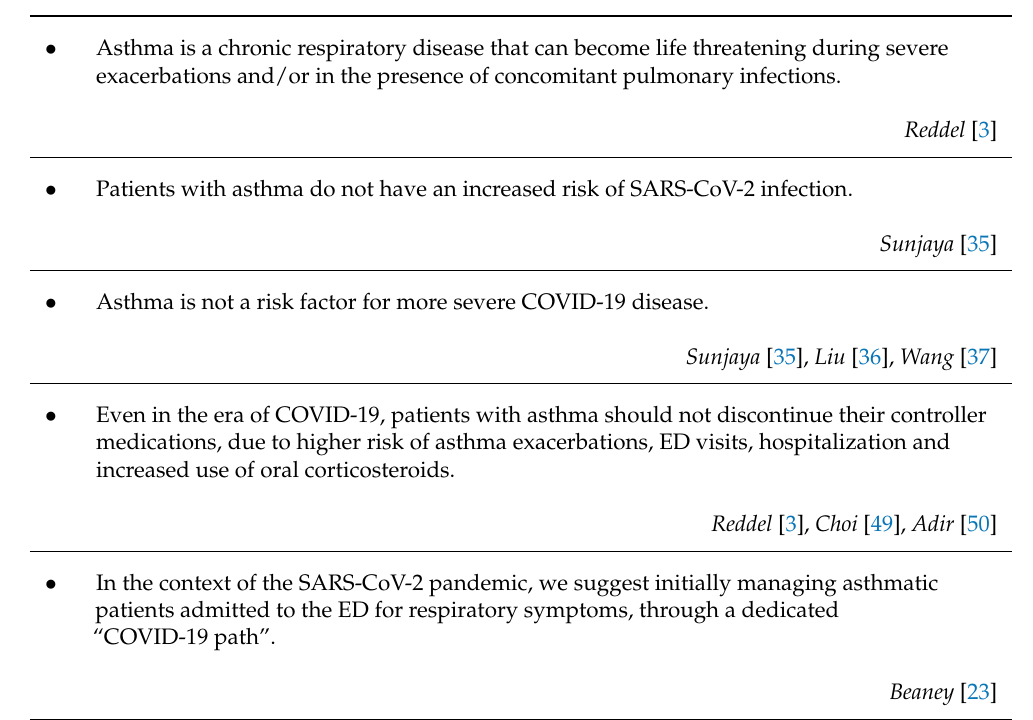
Table 2. Key points to guide the management of adult patients with asthma in the emergency department